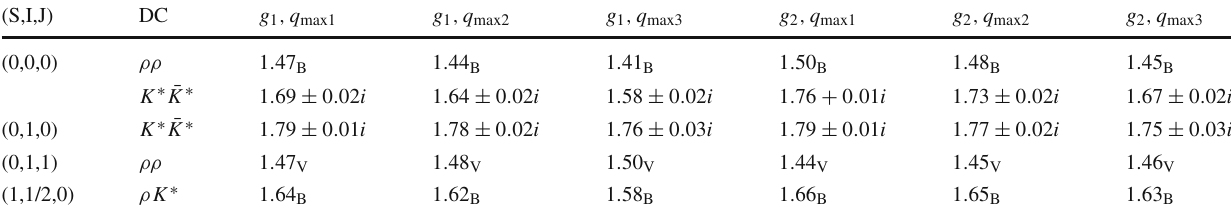
Table 3 Poles (in units of GeV) found in different channels using dif- ferent values of the coupling g and cutoff q max . Here, g 1 = 4 . 596 and g 2 = 4 . 168, and q max1,2,3 = 0 . 775, 0.875 and 1.0 GeV, respectively. Only the poles located on the physical sheet and those on unphysical